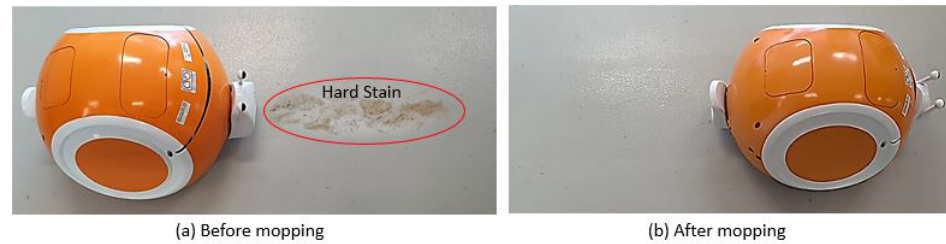
Figure 12. Cleaning efficiency of Snail when a removing hard